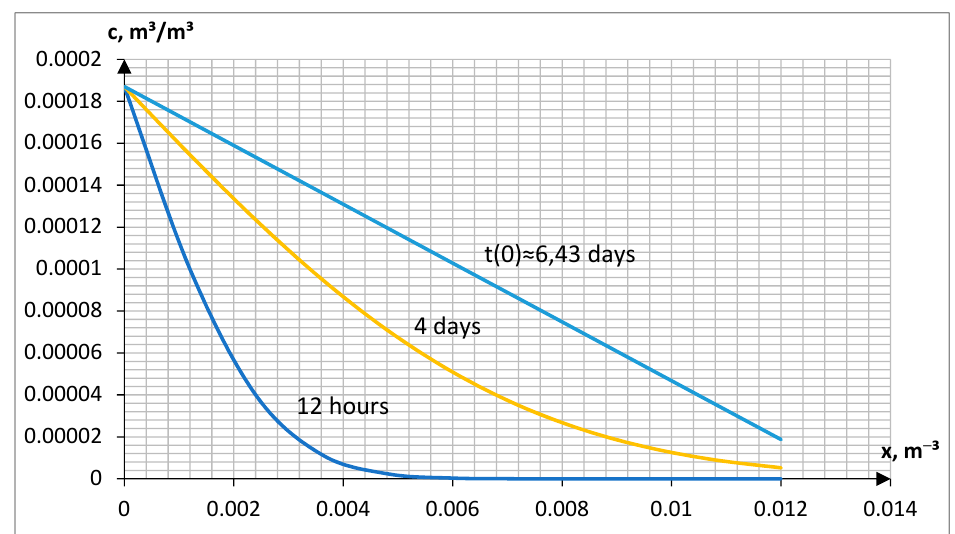
Figure 12. Distribution of hydrogen concentration over the pipe wall thickness under non-stationary and stationary modes at different moments of transportation (compiled by the authors).